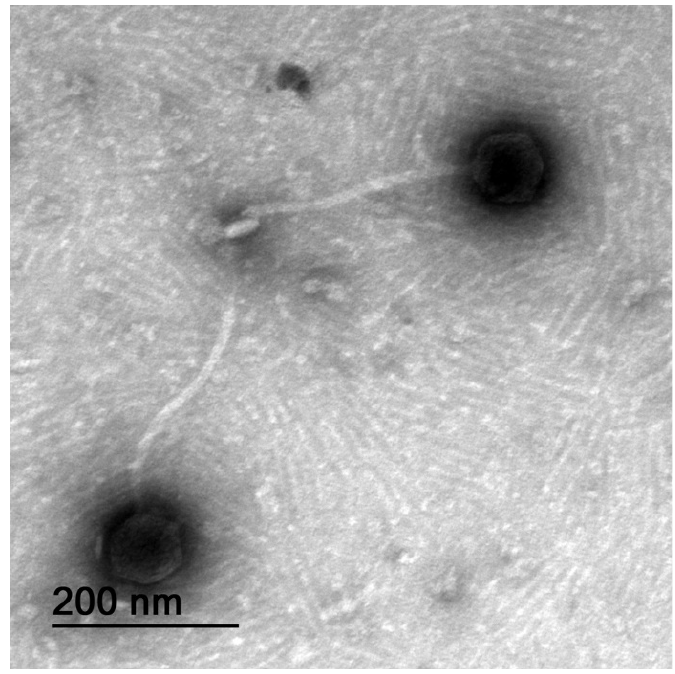
Figure 2. Negative-staining TEM photomicrograph of phage Kpn31 at ×100,000 magnification, allowing to clearly observe the nucleocapsid, the non-contractile thin tail, the tail tube, and the central tail spike at the distal part of the tail.